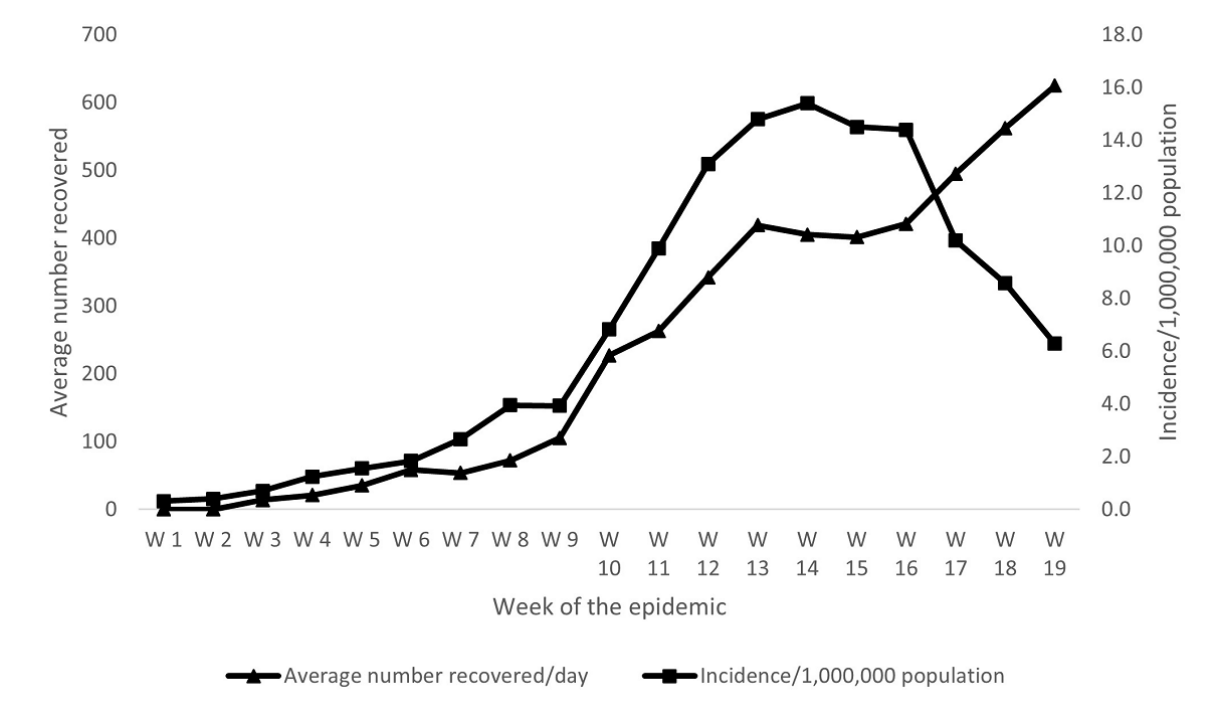
Figure 2. Incidence rate of COVID-19 and average number of recoveries in Egypt, February to July 2020. Source: Ministry of Health and Population daily COVID-19 report.